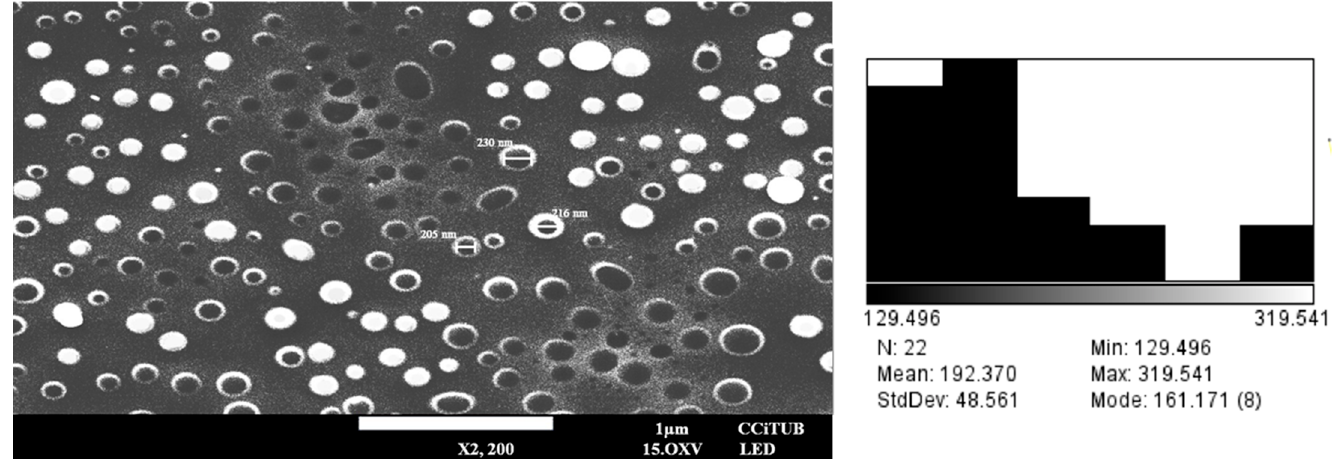
Figure 5. Scanning Electron Microscopy image of PF-NLCs-N6 and the related histogram.